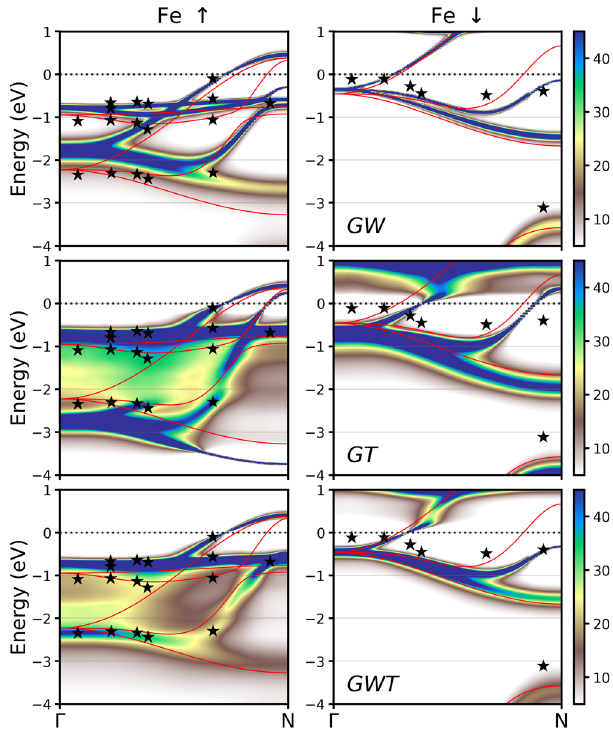
Fig. 2 Comparison of computed and experimental band struc- tures of bcc Fe. Spin-dependent band structures of bcc Fe are renormalized with GW , GT , and GWT self-energies along Γ – N and a smaller energy range. Experimental photoemission peak positions (black stars) are taken from ref. 33 .